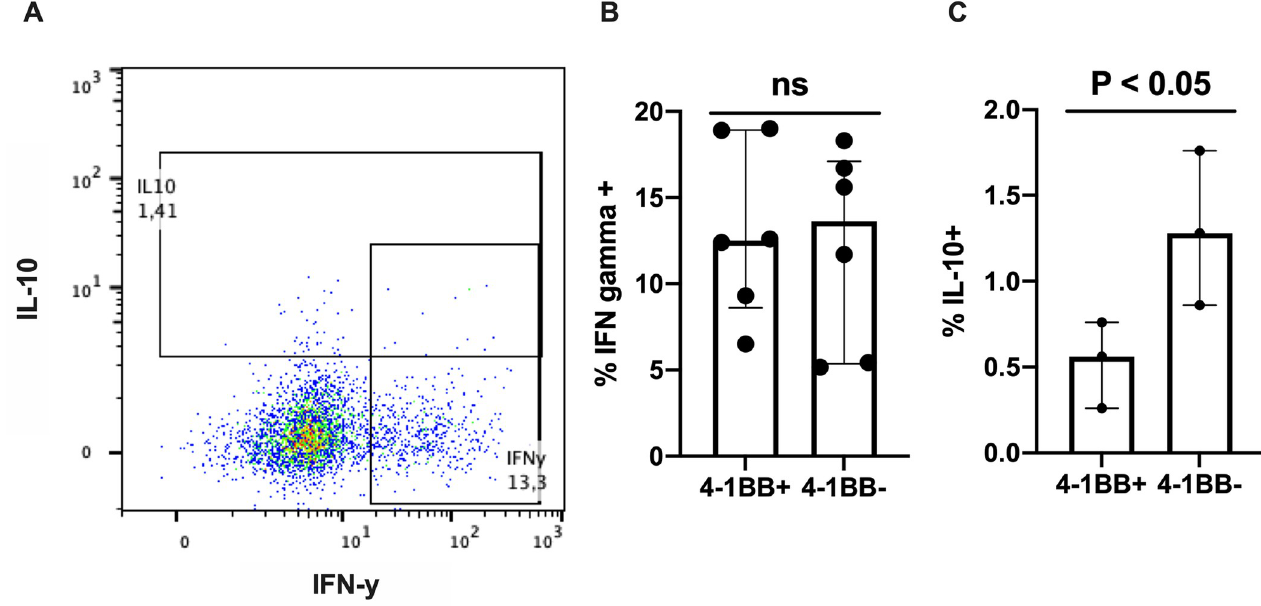
Fig 2. Cytokine production in 4-1BB + and 4-1BB - CD4 + T lymphocytes. Flow cytometry of peripheral blood mononuclear cells stimulated for 48 hours with anti-CD3 and anti-CD28 given PMA and brefaldin-A for the last 4 hours. (A) Typical flow cytometry plot of 4-1BB + CD4 + T lymphocytes from a patient with alcoholic hepatitis showing interferon- γ (IFNy) on x-axis and interleukin-10 (IL-10) on y-axis. Frequencies of interferon- γ + (B, n = 6) and IL-10 + (C, n = 3)) 4- 1BB + and 4-1BB - CD4 + T lymphocytes in patients with alcoholic hepatitis. Differences between groups compared using paried T test. Graphs shown as median with interquartile